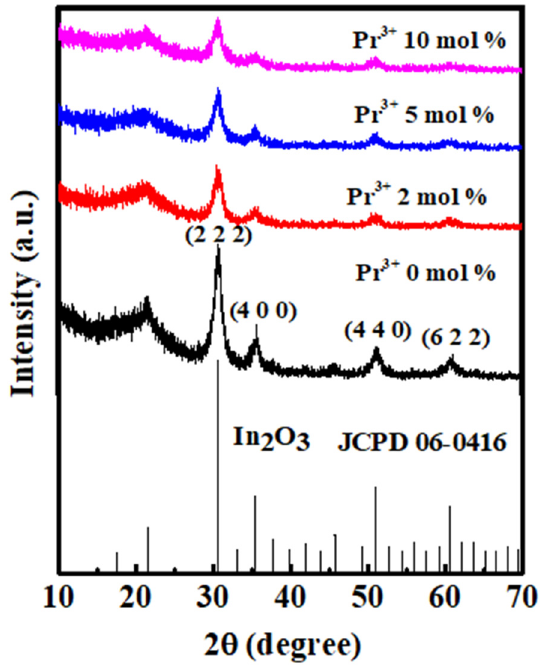
Figure 2. Grazing incidence X-ray diffraction patterns for In-Pr-O layers with 0, 2, 5, and 10 mol% Pr concentration.